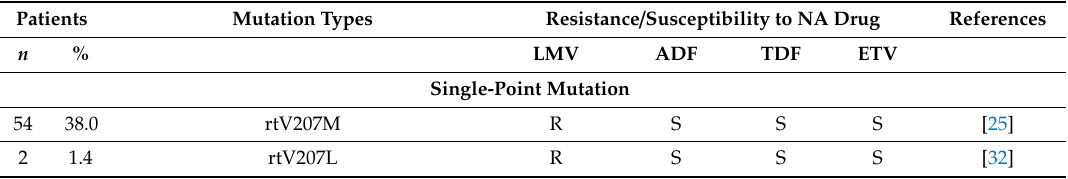
Table 3. Profile of Nucleos(t)ide-analogue (NA) drug resistance-associated mutations in treatment-naïve children with chronic hepatitis